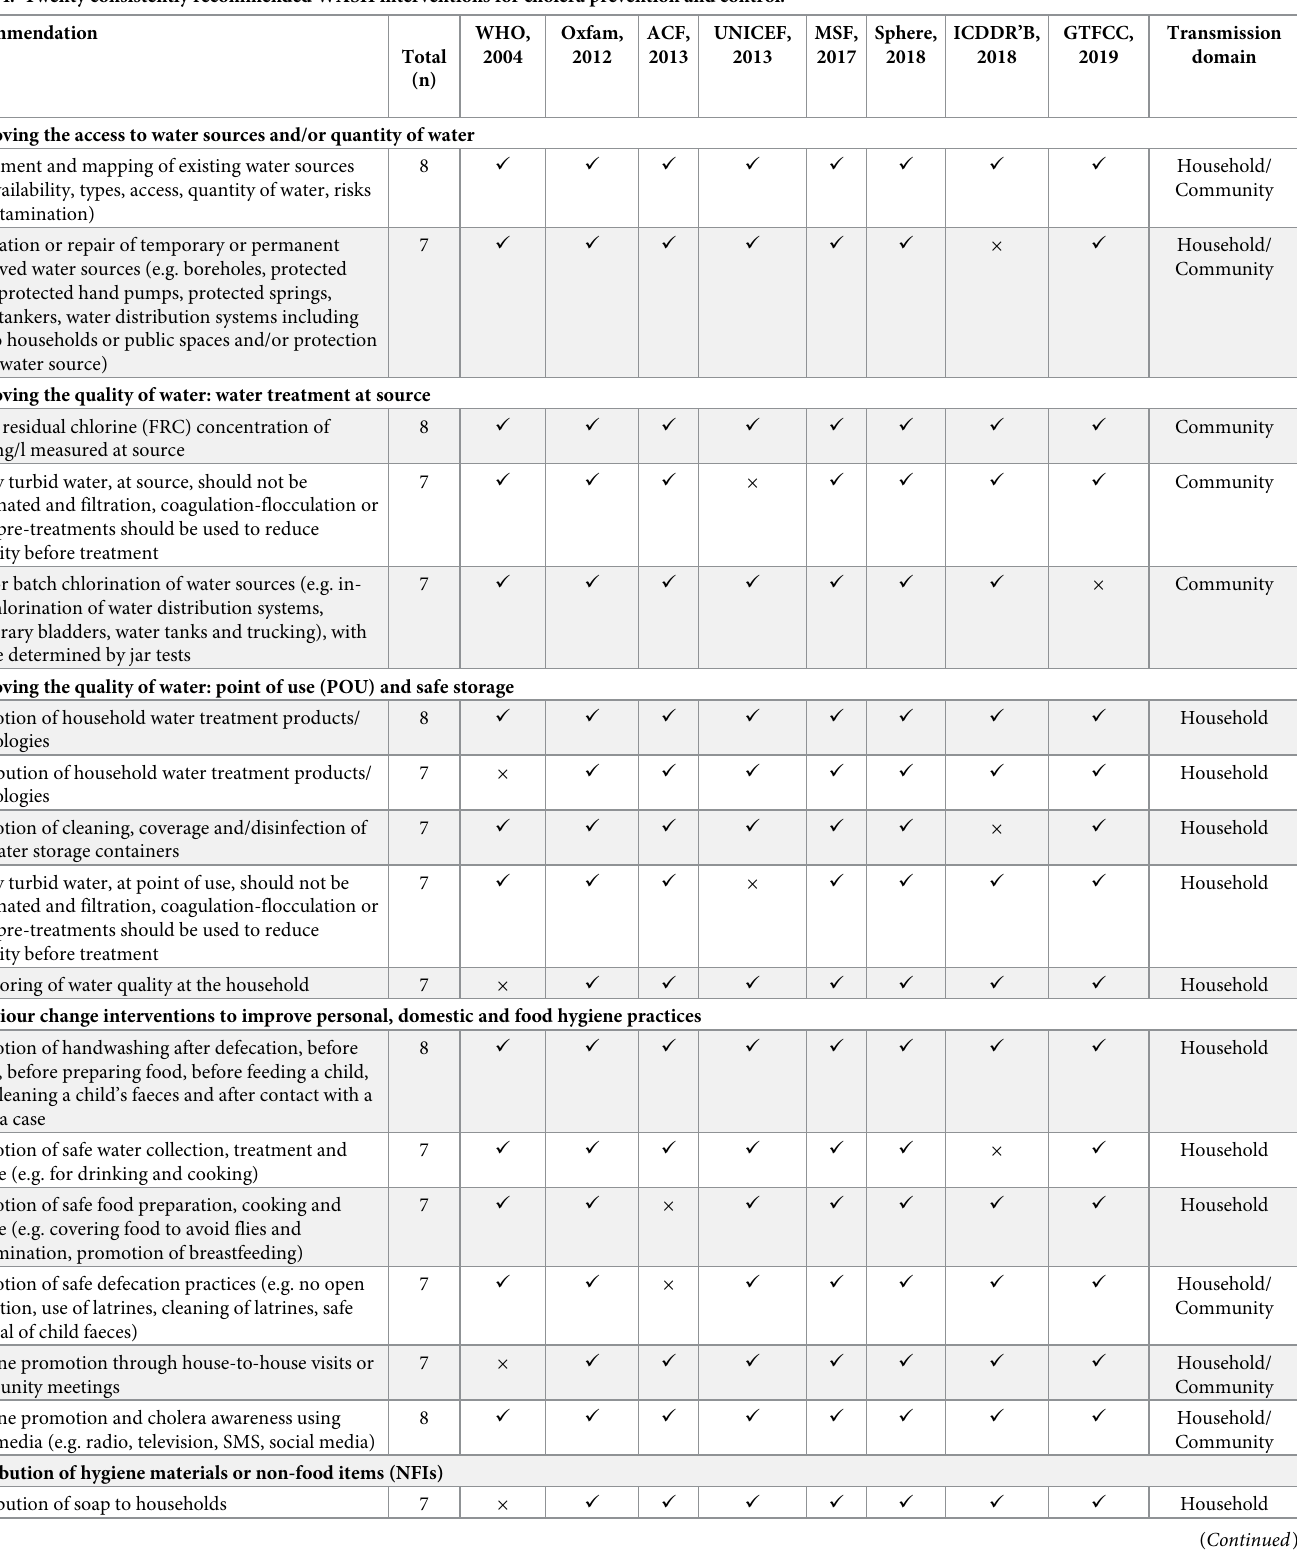
Table 4. Twenty consistently recommended WASH interventions for cholera prevention and